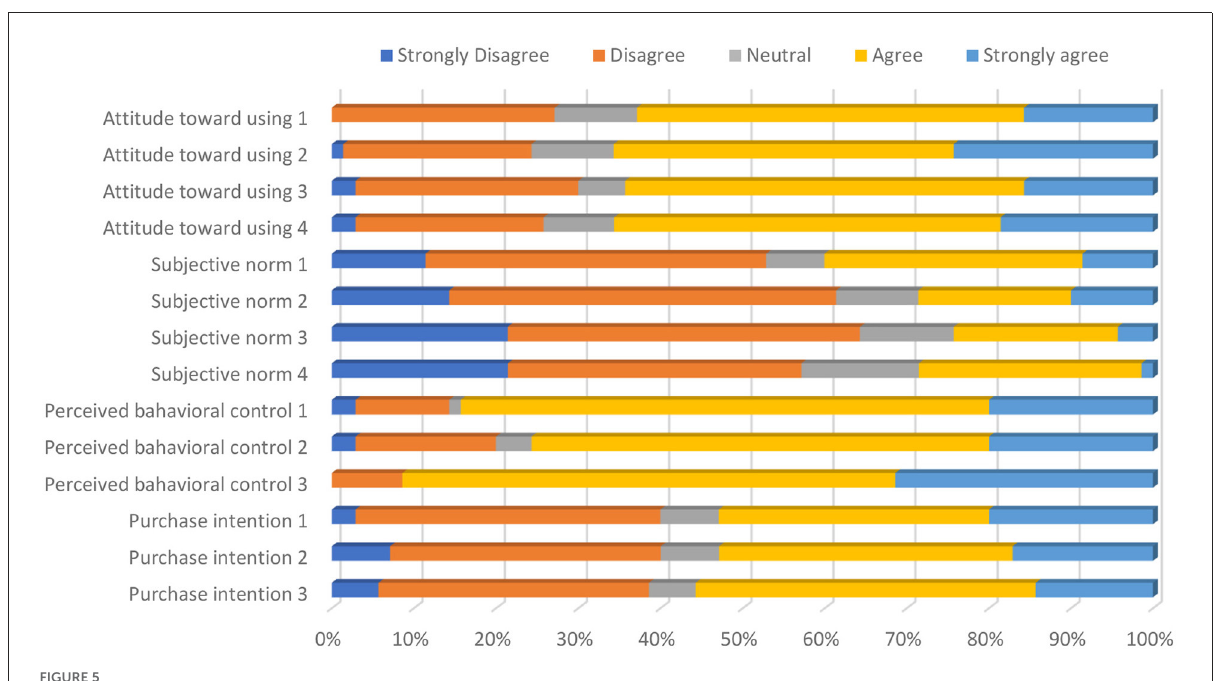
FIGURE5 Explanation for each domain affects the customer who don’t won smartwatch on Saudi Arabia.